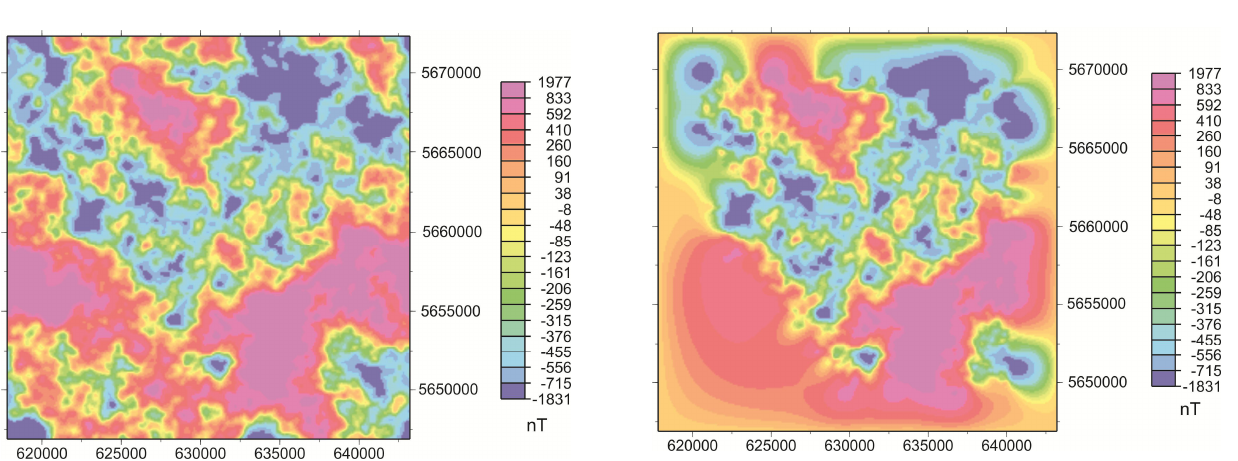
Fig. 3. Synthetic fractal magnetic grid upward continued to a height of 125 m. Note the periodicity of the grid. Top and bottom edges are identical as well as left and right edges. Coordinates in metres are UTM zone 21.